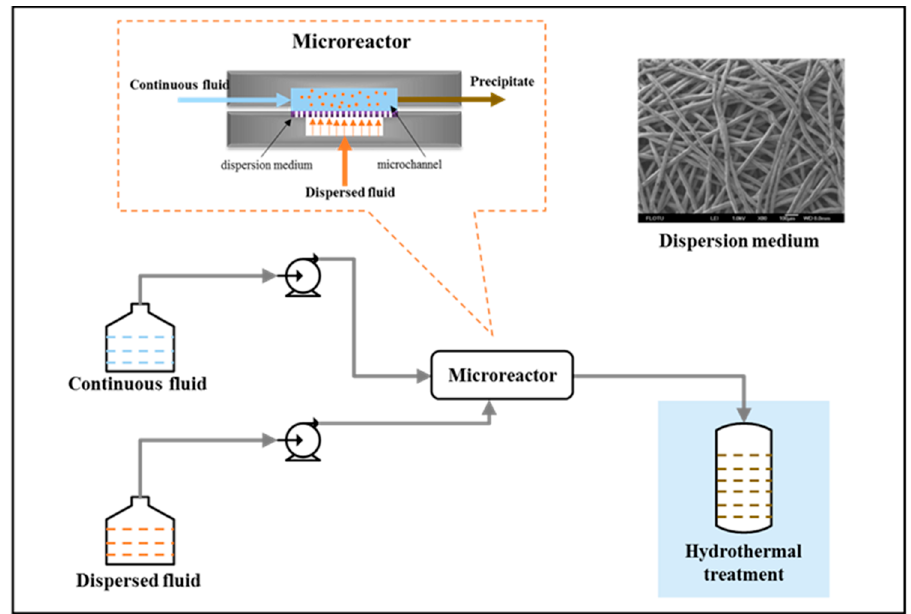
Figure 12. Schematic of the experimental process.